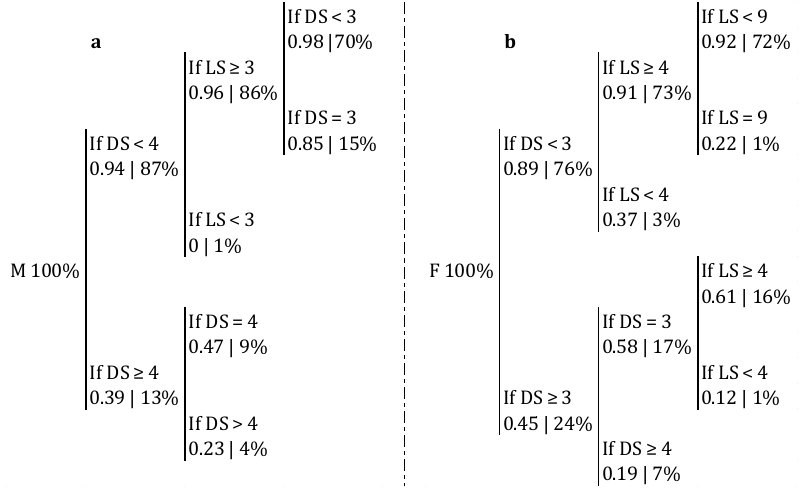
Figure 4. Probability of first tempo availability in male ( a ) and female ( b ) category depending on the LS and the DS. M: male category; F: female category; LS: latitude of the setter in the moment of set; DS: depth of the setter in the moment of set.